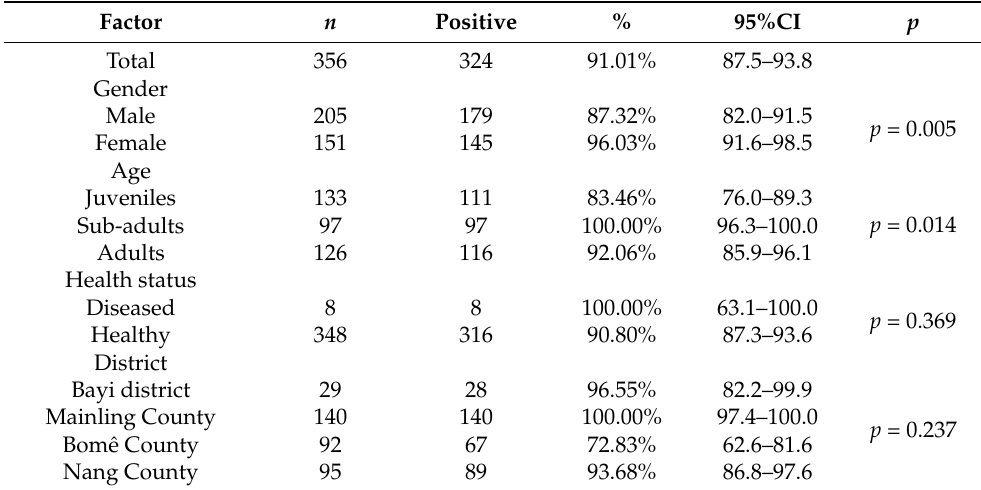
Table 1. Relationship between Tibetan pig characteristics and PPV serological status, and correspond- ing 95% confidence interval (CI), p value.